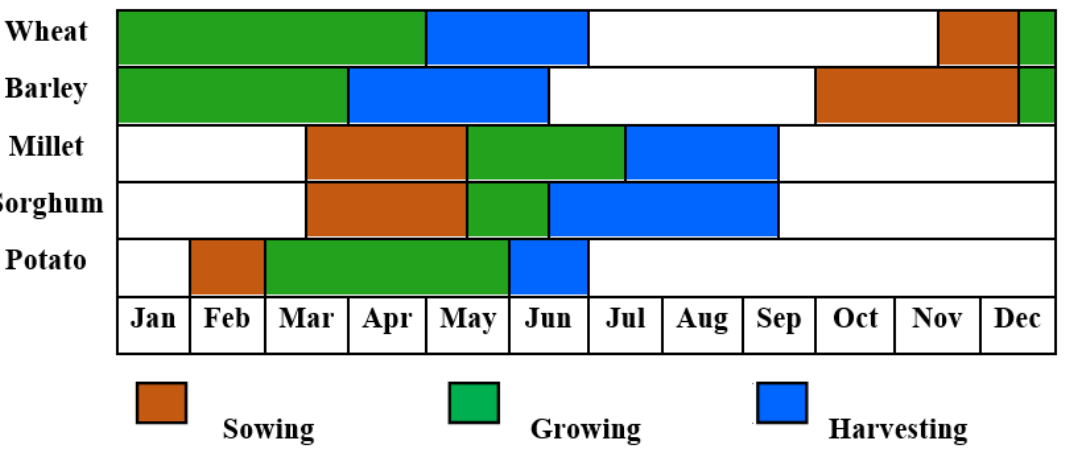
Figure 3. The crop seasons for the Iraq region.